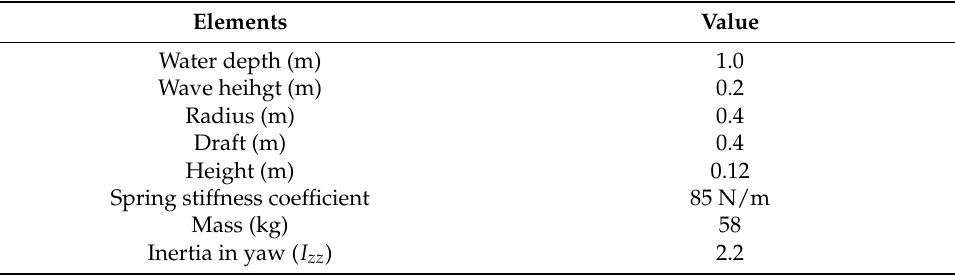
Figure 9. Physical model experiment. Table 5. Particulars and test conditions of the WEC.